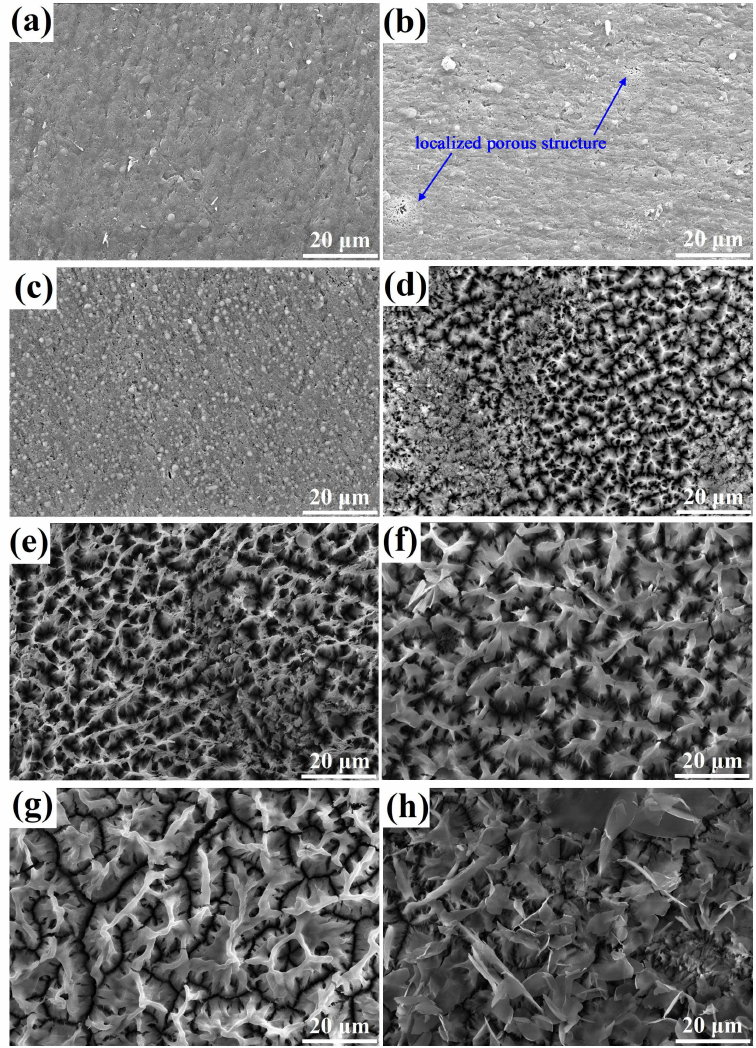
Figure 3. Scanning electronic microscope (SEM) surface morphologies of the coated samples with di ff erent anodizing durations: ( a , c , e , g ) are the cast-coated samples anodized for 10, 25, 30, and 40 min, respectively; ( b , d , f , h ) are the ECAP-coated samples anodized for 10, 25, 30 and 40 min,